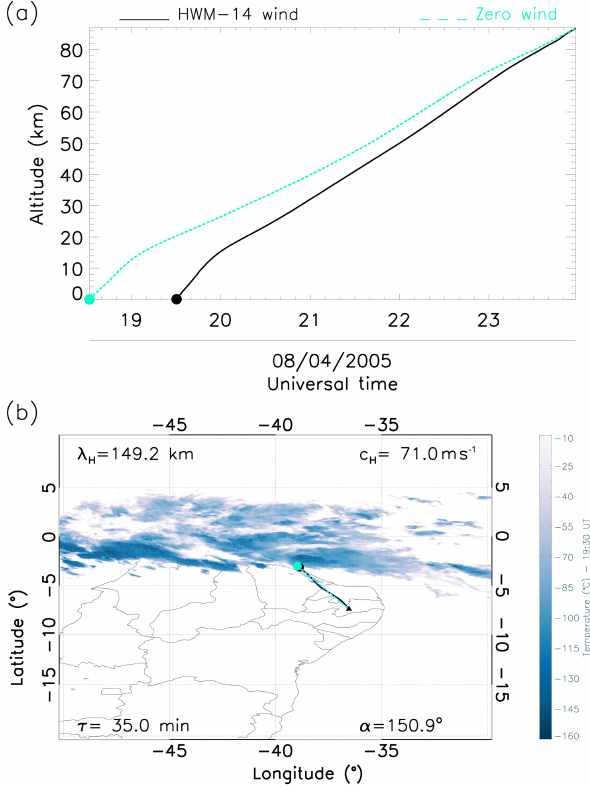
Figure 7. Same as Fig. 4 but for GW 4 .